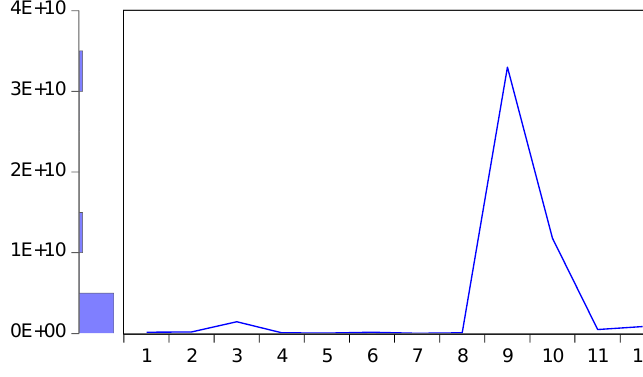
Figure 3. Total equity.